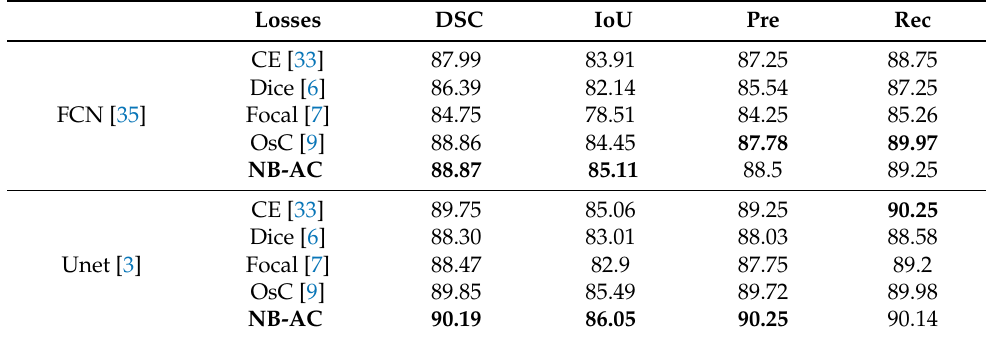
Table 4. Comparison between our proposed NB-AC loss against other losses CE [33], Dice [6], Focal [7], and OsC [9] on the iSeg 2017 dataset with the corresponding two network backbones 2D-FCN [35] and 2D-Unet [3]. The best performance is shown in bold . Losses DSC IoU Pre Rec CE [33] FCN [35]